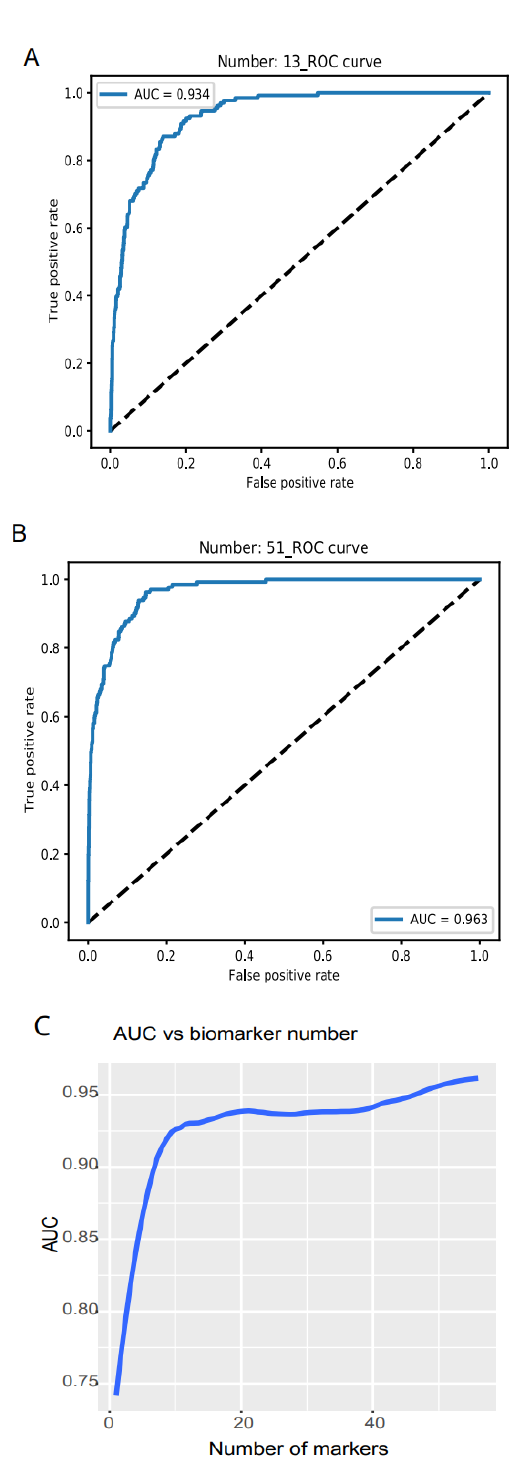
Figure 2. Binary discrimination of cancer and normal. Noncoding RNA biomarkers and deep learning neural network accurately discriminate 26 cancers from healthy objects. ( A ) Neural network model ROC curve of 13 accumulated biomarkers. In total, 13 biomarkers can discriminate cancers from normal with 0.934 of AUC. ( B ) In total, 51 accumulated biomarkers detected cancers with 0.963 AUC. ( C ) AUC vs. the number of accumulated biomarkers from 1 to 56.